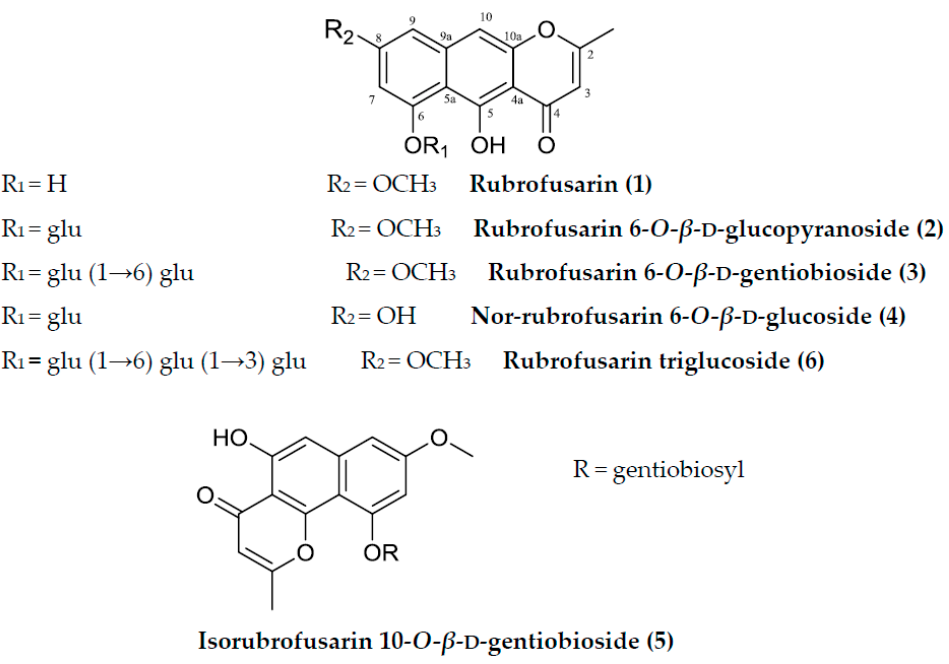
Figure 1. Structures of the compounds isolated from C. obtusifolia .